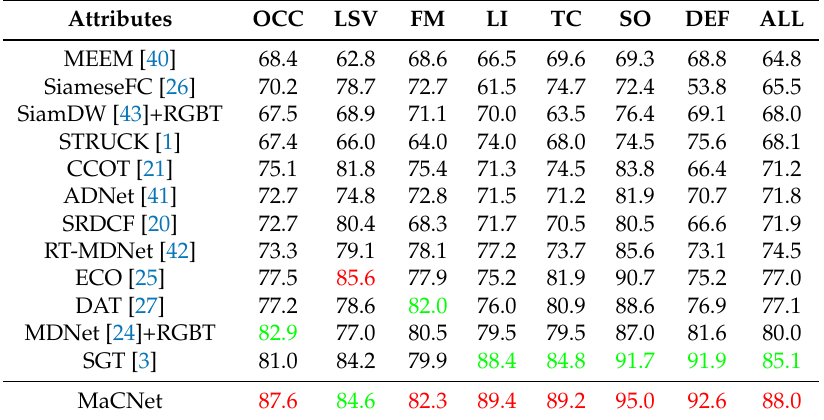
Table 3. Attribute-based PR scores (%) on GTOT dataset [12] against with twelve RGB-T trackers. Optimal and suboptimal results are represented by red and green fonts, respectively.